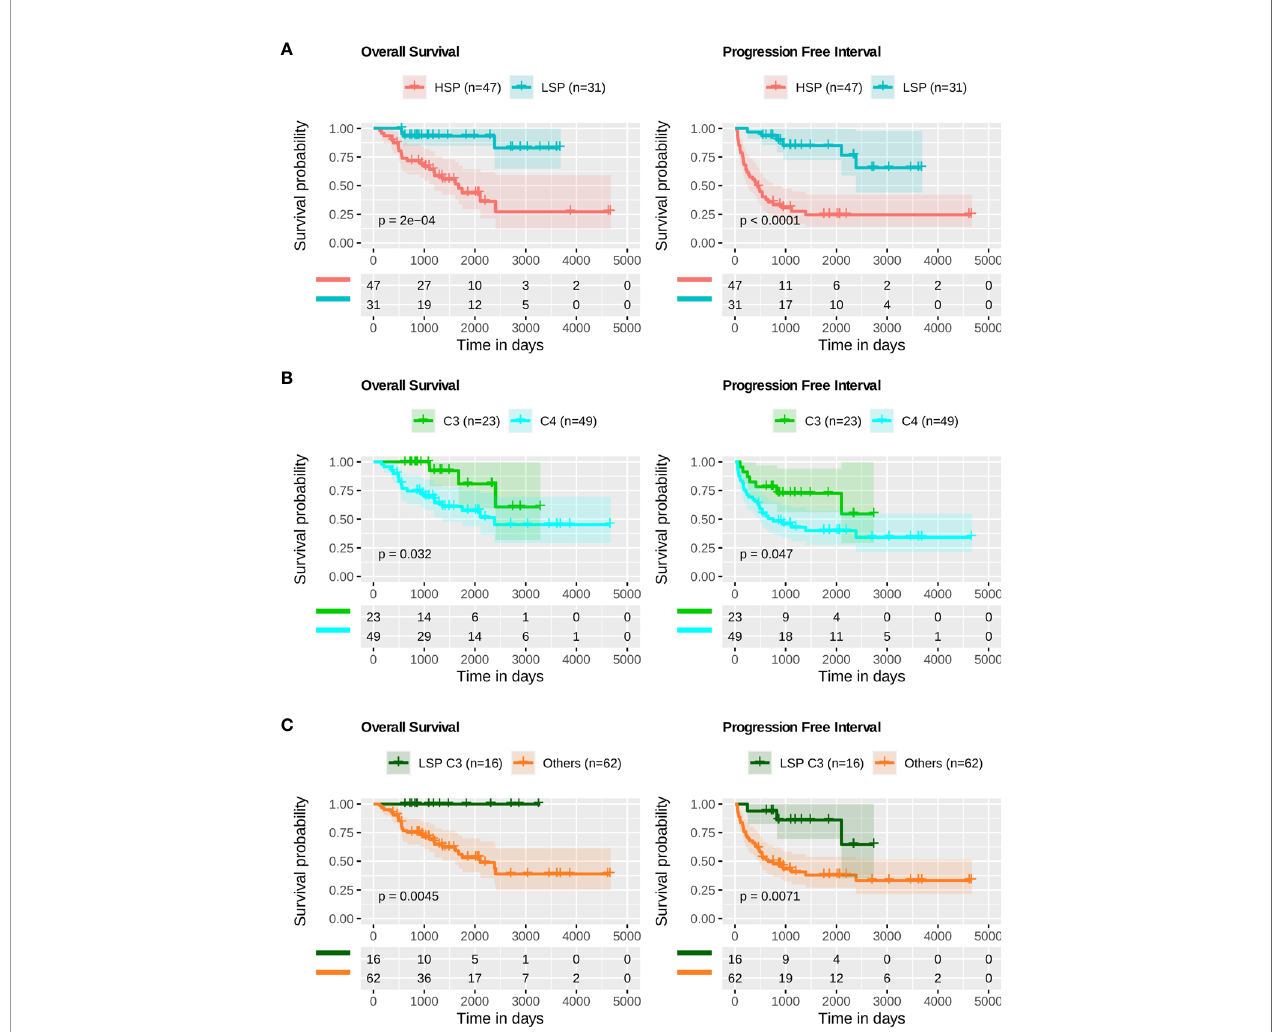
FIGURE 9 | Survival analysis. Kaplan-Meier analysis for overall survival (OS) and progression free interval (PFI) of ACC pro fi les. The p-value was calculated using a log-rank test and the con fi dence interval is shown. Below each plot a survival table with the absolute number of participants over time. (A) OS and PFI for LSP (n = 31) versus HSP (n = 47). (B) OS and PFI for immune subtype C3 (n = 23) versus immune subtype C4 (n = 49). (C) OS and PFI for LSP and C3 patients (n = 16) versus other combinations (LSP C2, C4, C5, and C6, or HSP C1, C3, C4, and C5; total n =